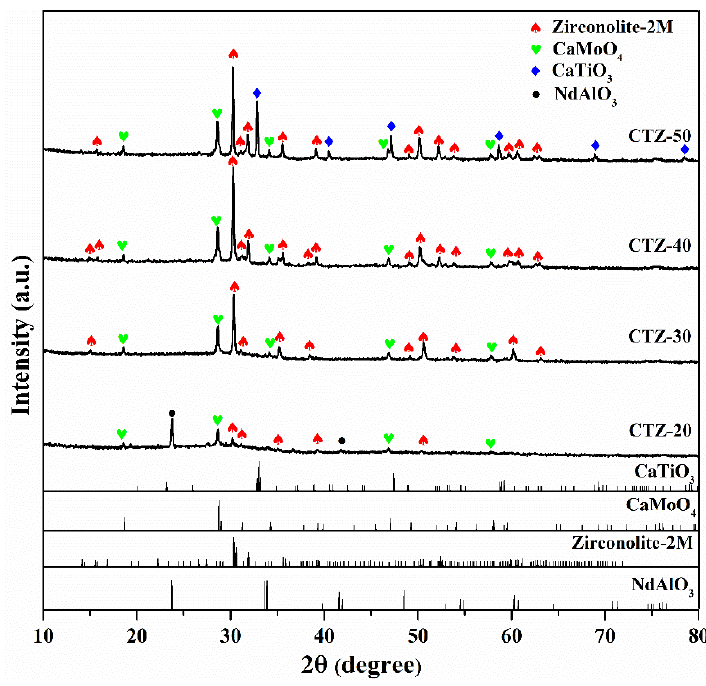
Figure 3. XRD patterns of glass-ceramics: CTZ-20, CTZ-30, CTZ-40 and CTZ-50.